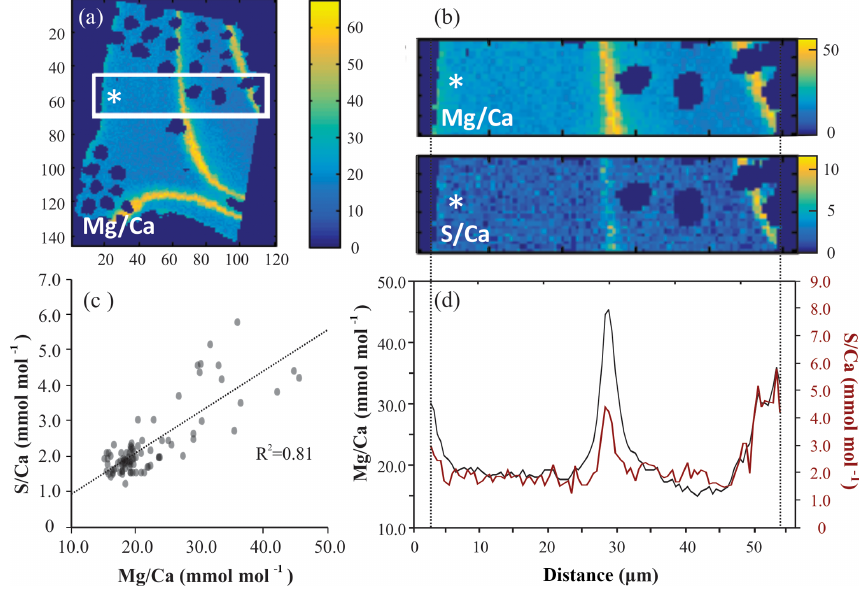
Figure 1. Example of EPMA data treatment from Amphistegina lessonii (top left specimen in Fig. S3): (a) general overview of Mg / Ca EPMA map with transect selection; (b) selection of the map from (a) to isolate a transect of Mg / Ca EPMA (top) and S / Ca EPMA (bottom); (c) average S / Ca EPMA and Mg / Ca EPMA values plotted per column with the R 2 for the regression analysis; (d) average E/ Ca EPMA of transect – Mg / Ca EPMA in black, S / Ca EPMA in red. Asterisks indicate the outer side of the foraminiferal shell. Color scale is “parula” provided by the software.